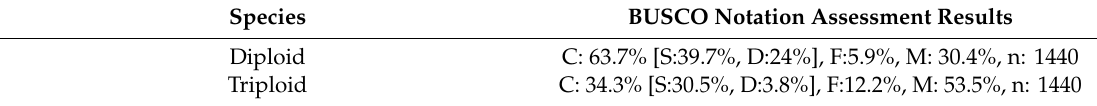
Table 2. BUSCO results (genome completeness) for diploid and triploid samples of C. thalictroides